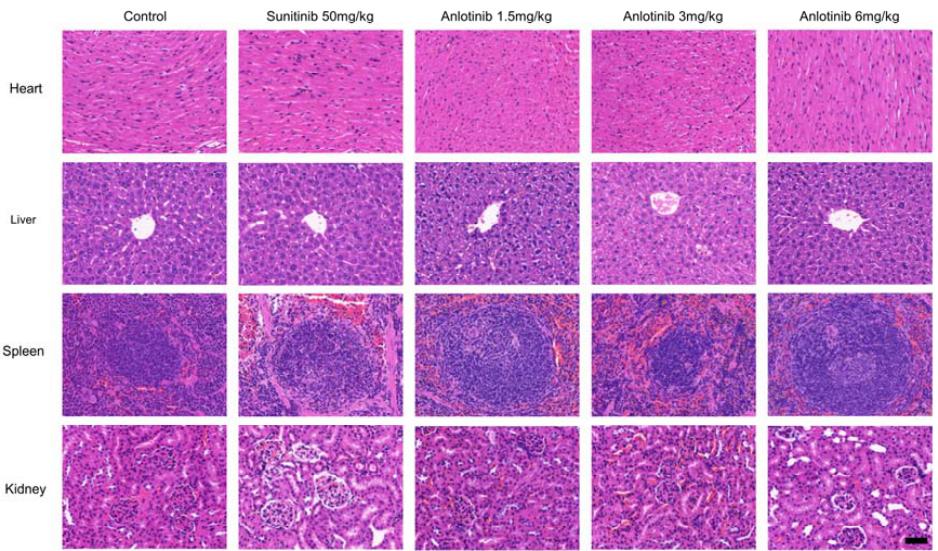
Figure 5. Representative images of H&E staining of heart, liver, spleen and kidney from the control and treatment groups. Bar = 100 μ m .